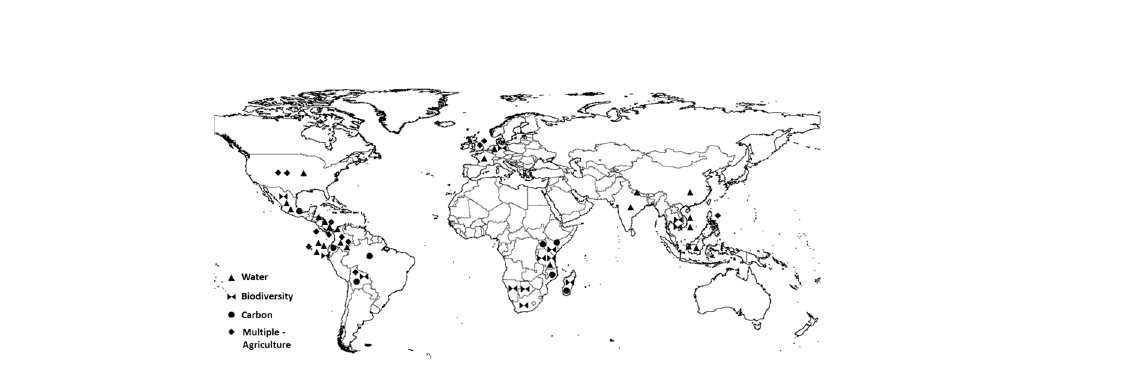
PLOS ONE | DOI:10.1371/journal.pone.0149847 March 3,